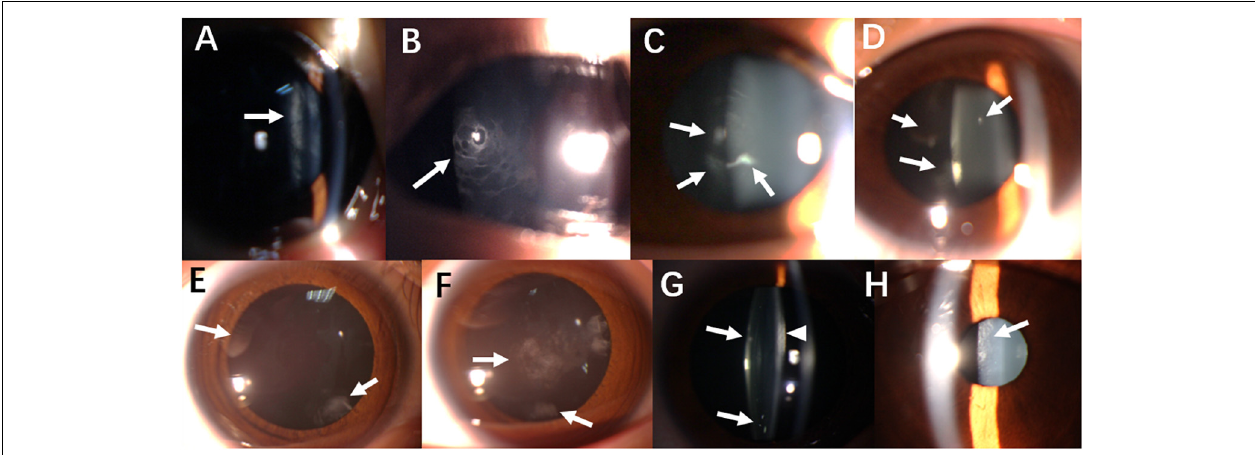
FIGURE 1 | Slit-lamp biomicroscopy photography showing lens opacity characteristics. (A) Cortex mass opacity (arrow) in the right eye of Case 1. (B) Non-uniformed rarefied cloudy opacity of posterior capsule (arrow) in the left eye of Case 2. (C) Posterior capsule opacity (arrow) in the right eye of Case 3. (D) Similar finding (arrow) was observed in the left eye of Case 3. (E) Posterior sub-capsule opacity (arrow) in the right eye of Case 4. (F) Similar finding (arrow) was observed in the left eye of Case 4. (G) Snowflake-like cortex opacity (arrow) and evenly condensed cortex (arrowhead) in the left eye of Case 5. (H) Rarefied cloudy opacity of posterior capsule (arrow) in both eyes in Case